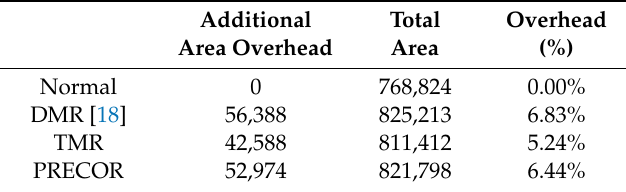
Table 2. Area overhead comparison (nm 2